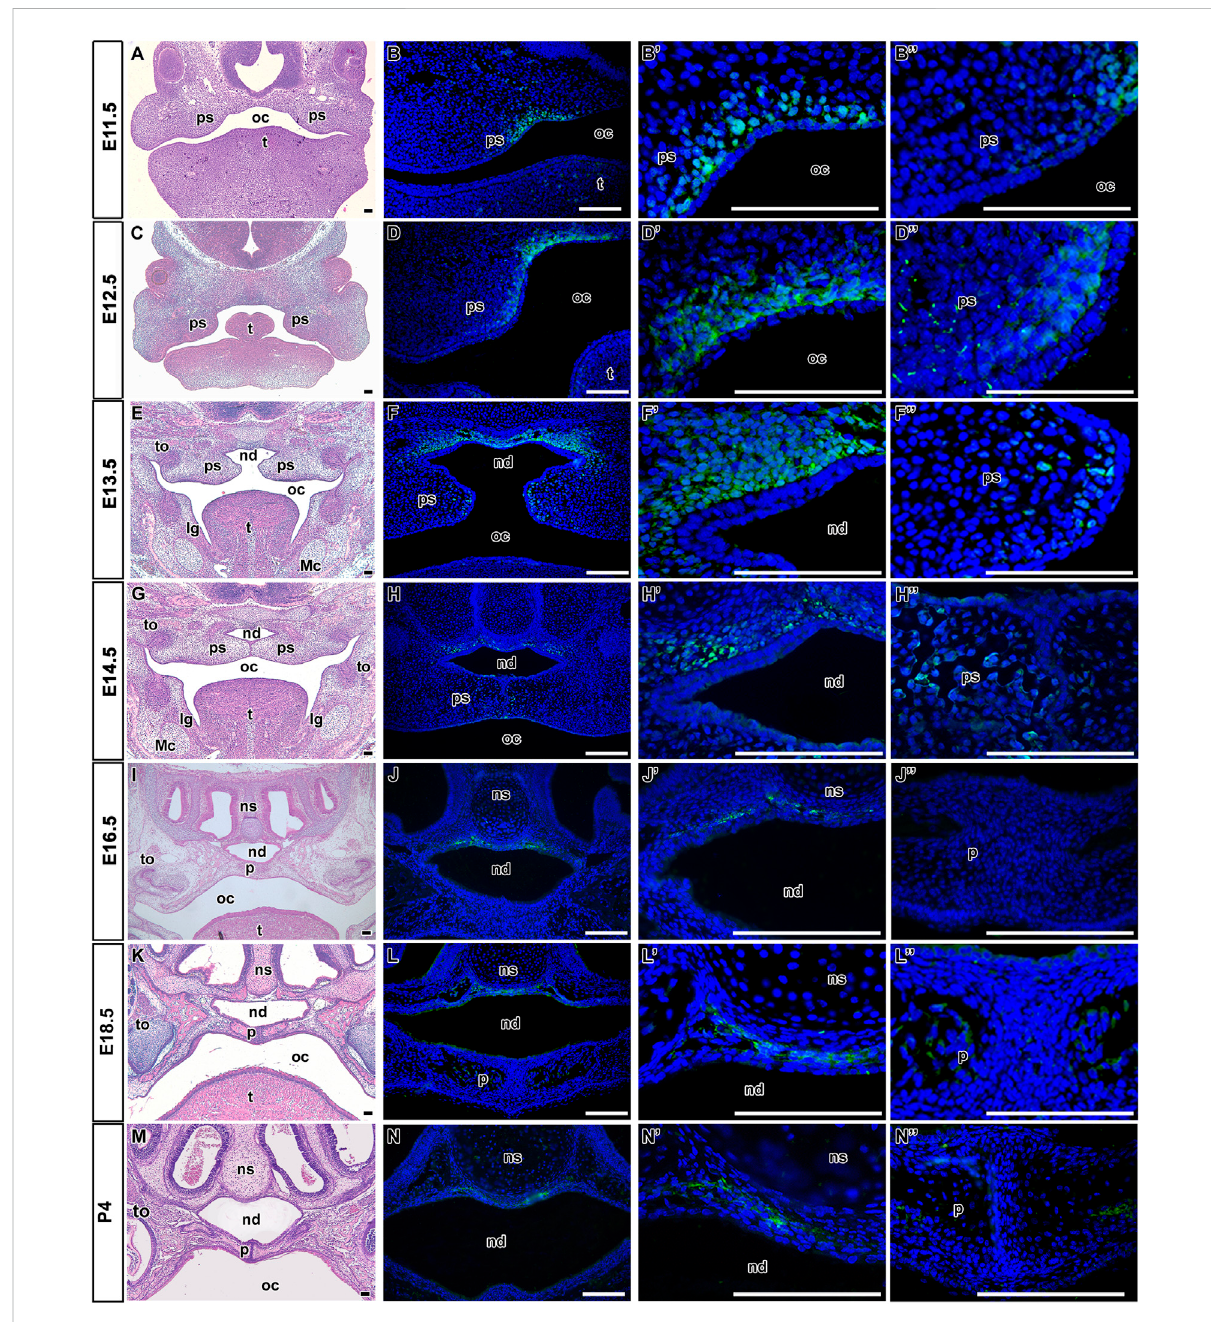
FIGURE 1 Distribution of LGR5-positive cells during palatogenesis. Hematoxylin-Eosin staining of transversal head sections at prenatal and postnatal stageswithfocusonthepalatalarea (A,C,E,G,I,K,M) .AtE11.5,LGR5-positivecellsarelocatedadjacenttotheepitheliuminthedorsalmesenchymeof formingpalatalshelves (B and B 9 ,B´´ indetail ) .LateratE12.5andE13.5,LGR5-positivesignalispresentinthedorsalmesenchymesurroundingfuture nasopharyngeal duct (D,F and D´,F´ in detail ) and in the mesenchyme of developing palatal shelves (D´´,F´´) . Next, LGR5-positive cells are situated in the mesenchyme surrounding the nasal septum ventrally from nasal cartilage at E14.5 (H,H´ in detail ) , E16.5 (J,J´ in detail ) , E18.5 (L,L´ in detail ) and P4 (N,N´ in detail) . Several LGR5-positive cells are located in the ventral palatal epithelium or in the mesenchyme of palatal shelves at E14.5 (H´´) . Weak to no expression of LGR5 is found in the epithelium and mesenchyme of palatal shelves at E16.5 (J´´) , E18.5 (L´´) and P4 (N´´) . lg, lingual groove; Mc, Meckel ’ s cartilage; nd, nasopharyngeal duct; ns, nasal septum; oc, oral cavity; p, palate; ps, palatal shelve; t, tongue; th, tooth. Scale bars = 100 μ